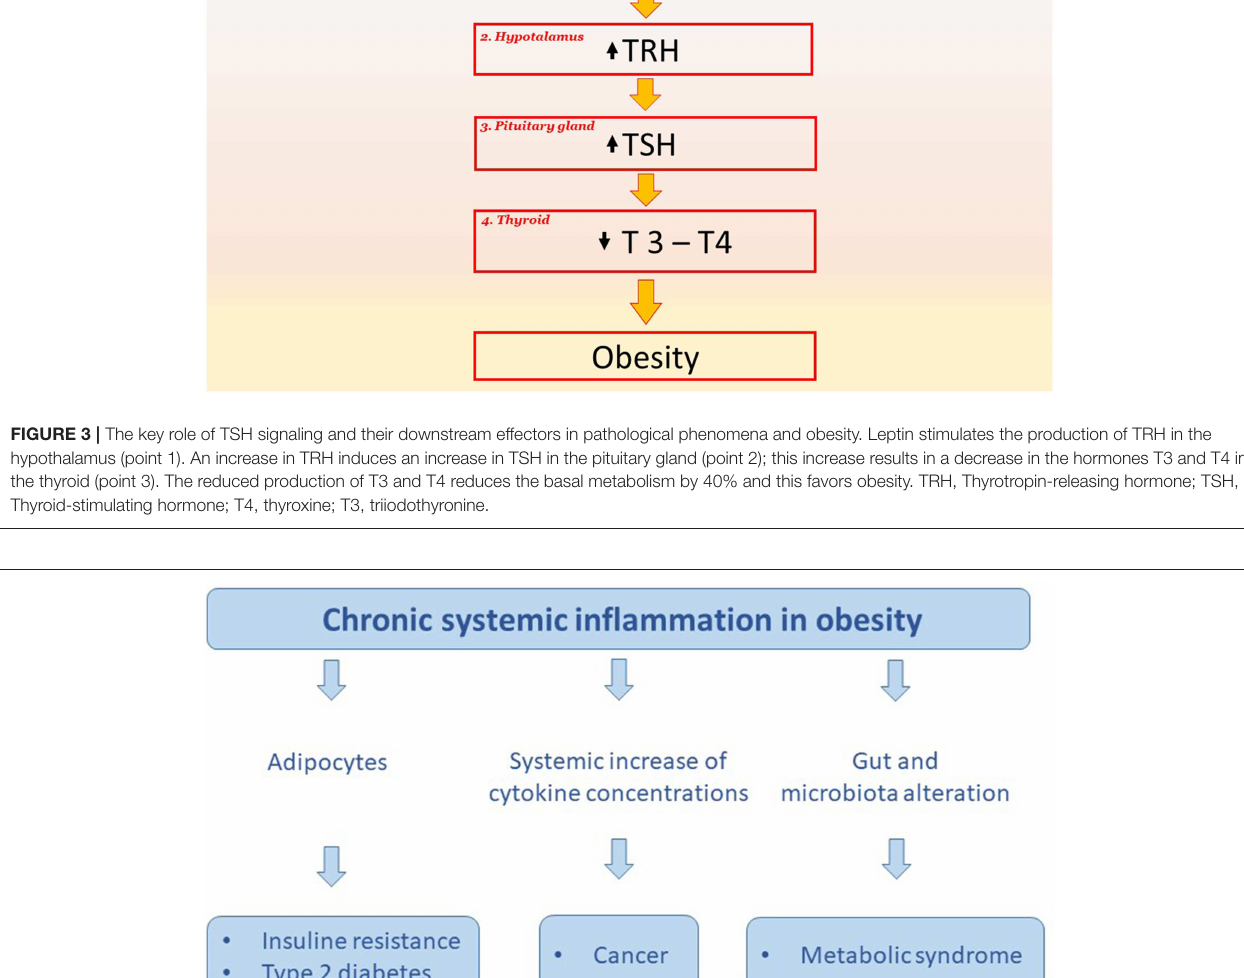
of the intestinal microbiota and, at the same time, weight loss is able to restore the normal intestinal microbial composition, confirming the link between microbiota and obesity (112,